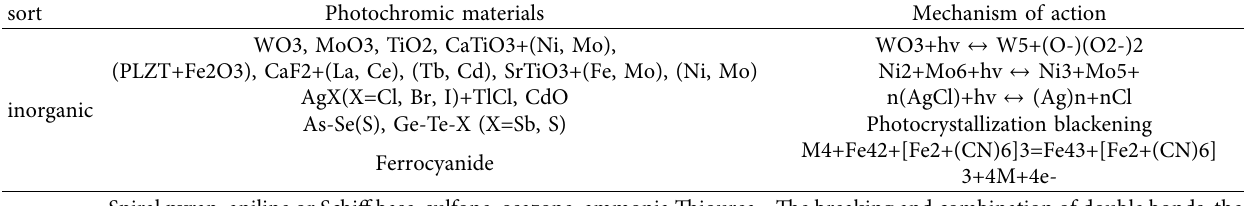
Table 4: Commonly used photochromic materials and their action mechanism.